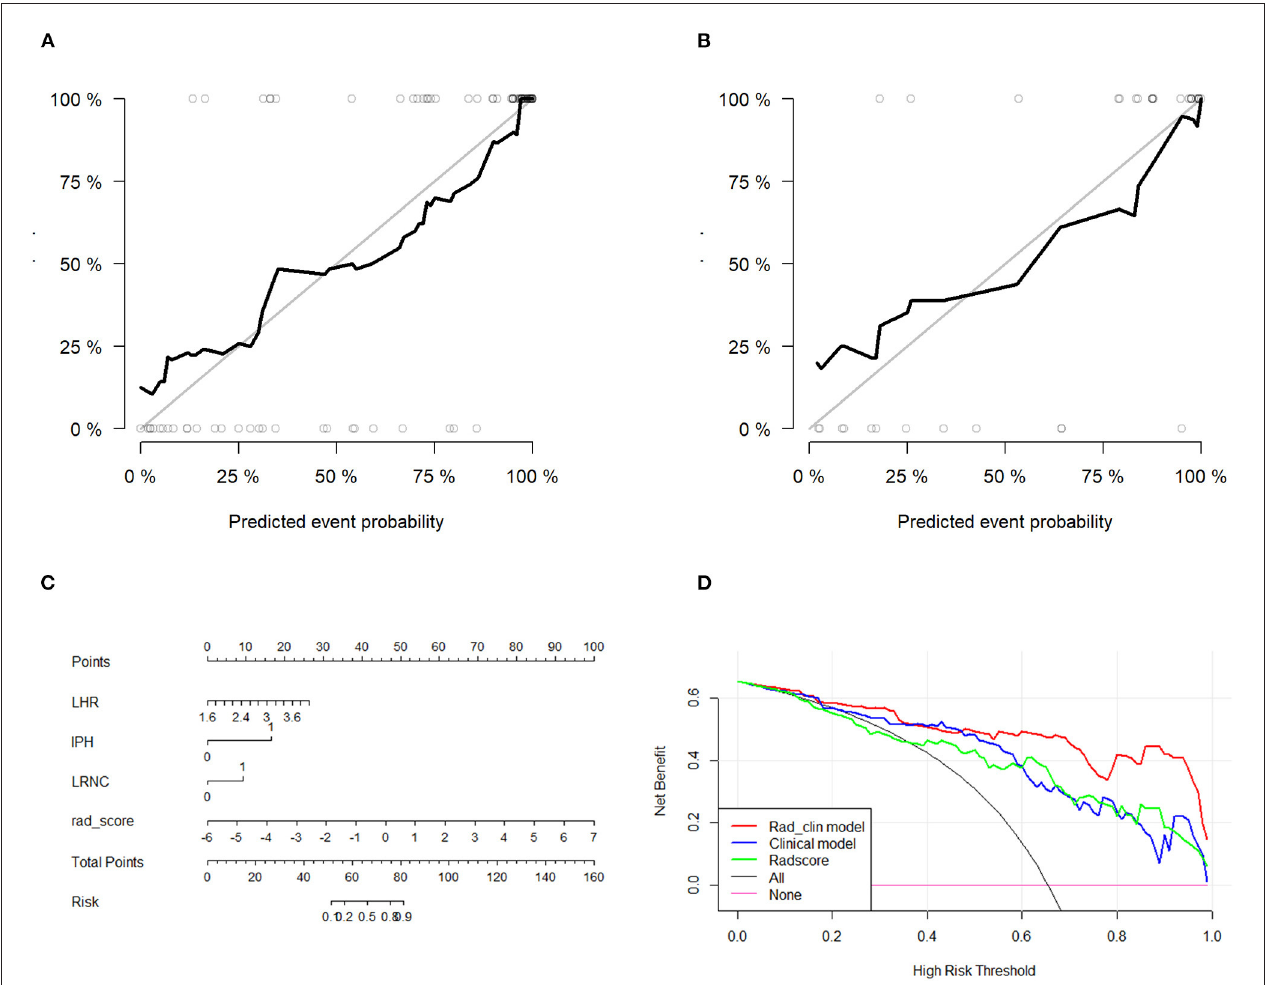
FIGURE 6 | Diagnostic performance evaluation in the training group and test group. Calibration curves of the nomogram in the training (A) and the test groups (B) . Calibration curves showed the calibration of the nomogram in terms of agreement between the predicted risk of vulnerable plaque and high-resolution magnetic resonance imaging (HRMRI)-observed vulnerable plaque. (C) Nomogram based on Rad_clin_model. (D) Decision curves for Radscore, clinical model, and Rad_clin_model; the Y-axis shows the model benefit. The red line represents the Rad_clin_model. The blue line represents the clinical model, and the green line represents the Radscore. The X-axis means the threshold probability. ROC, receiver operating characteristic; AUC, area under the